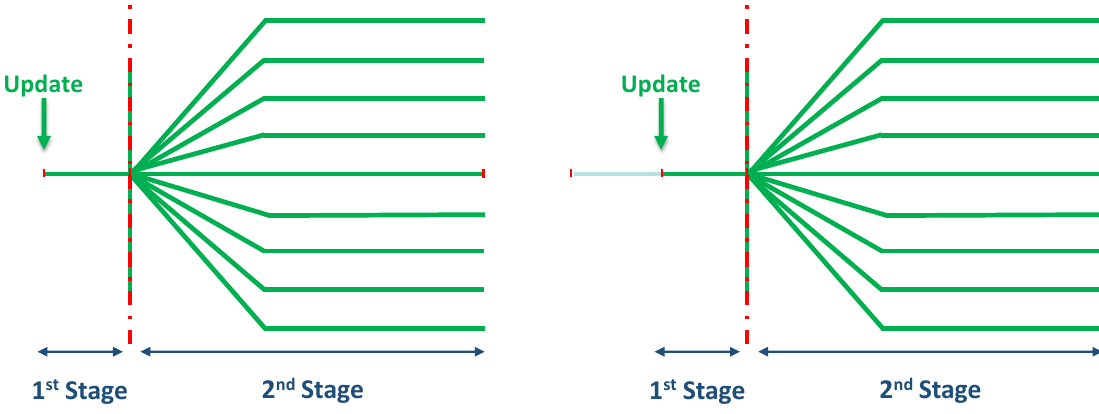
Figure 4. Two consecutive rolling horizon iterations of the two-stage stochastic